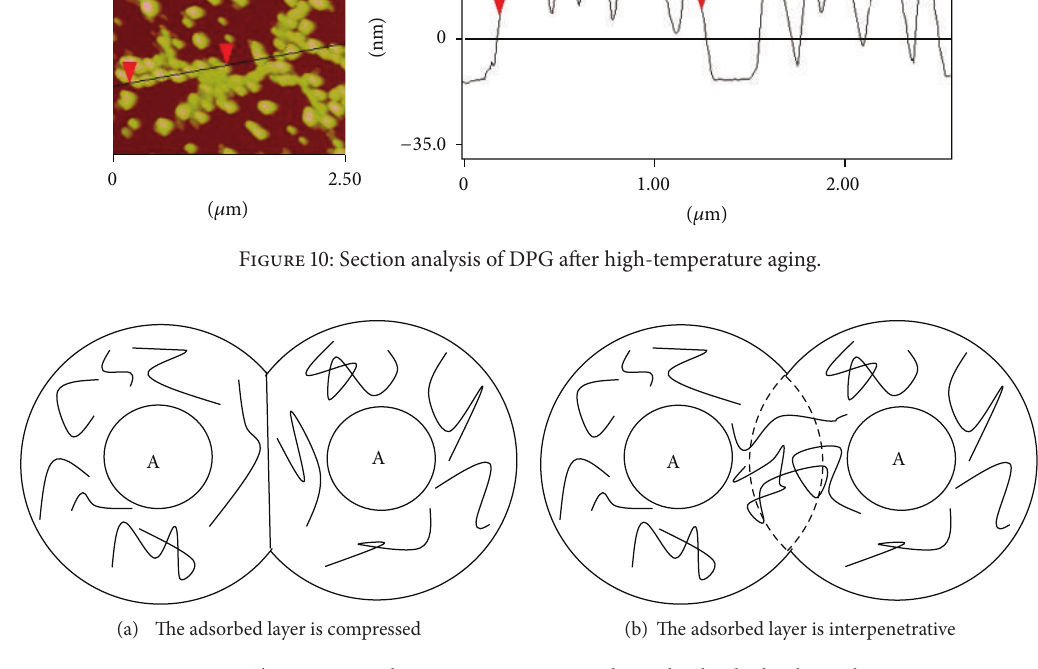
Figure 11: The interaction between two DPG particles with adsorbed polymer layers.